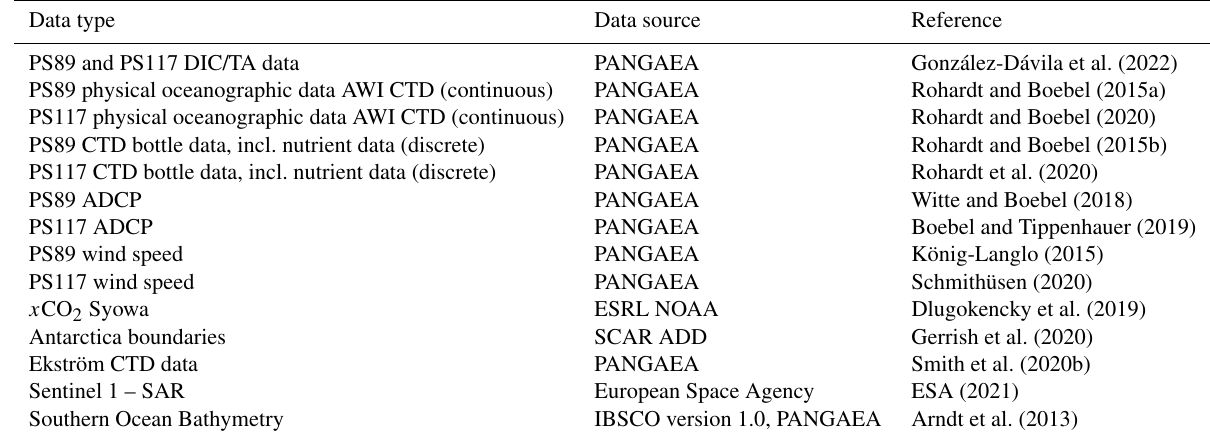
Table B1. References to all supporting data and data sources used in this